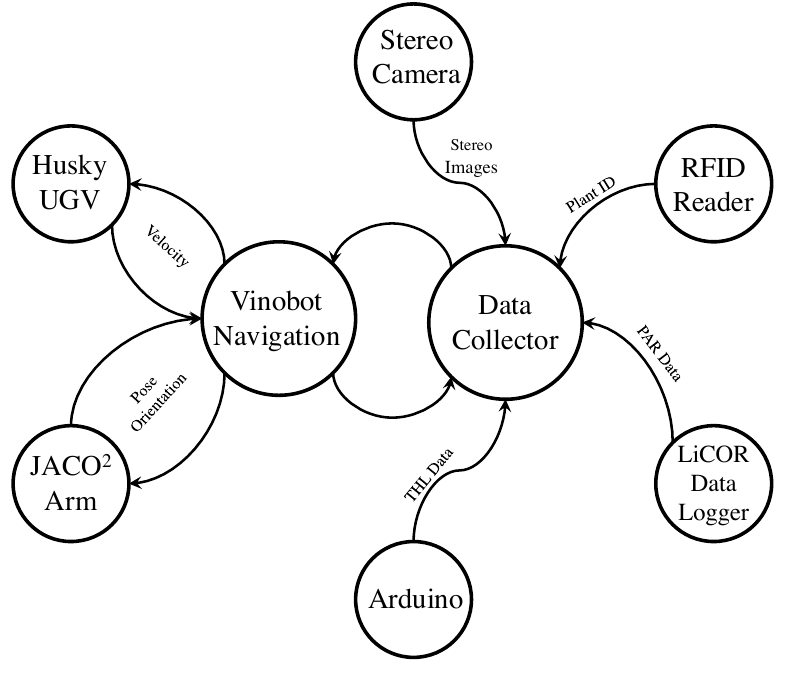
Figure 3. High-level software architecture of the